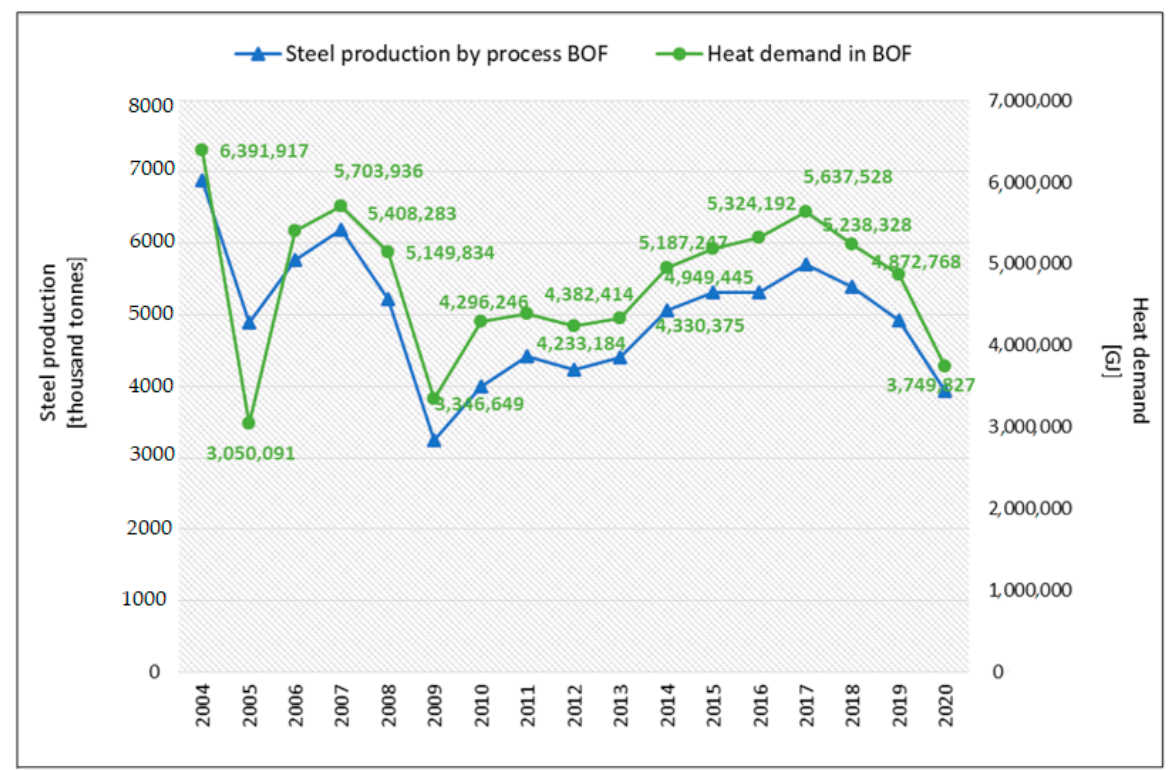
Figure 6. Total heat demand in the BOF process in Poland from 2004 to 2020. Source: Own elaboration.